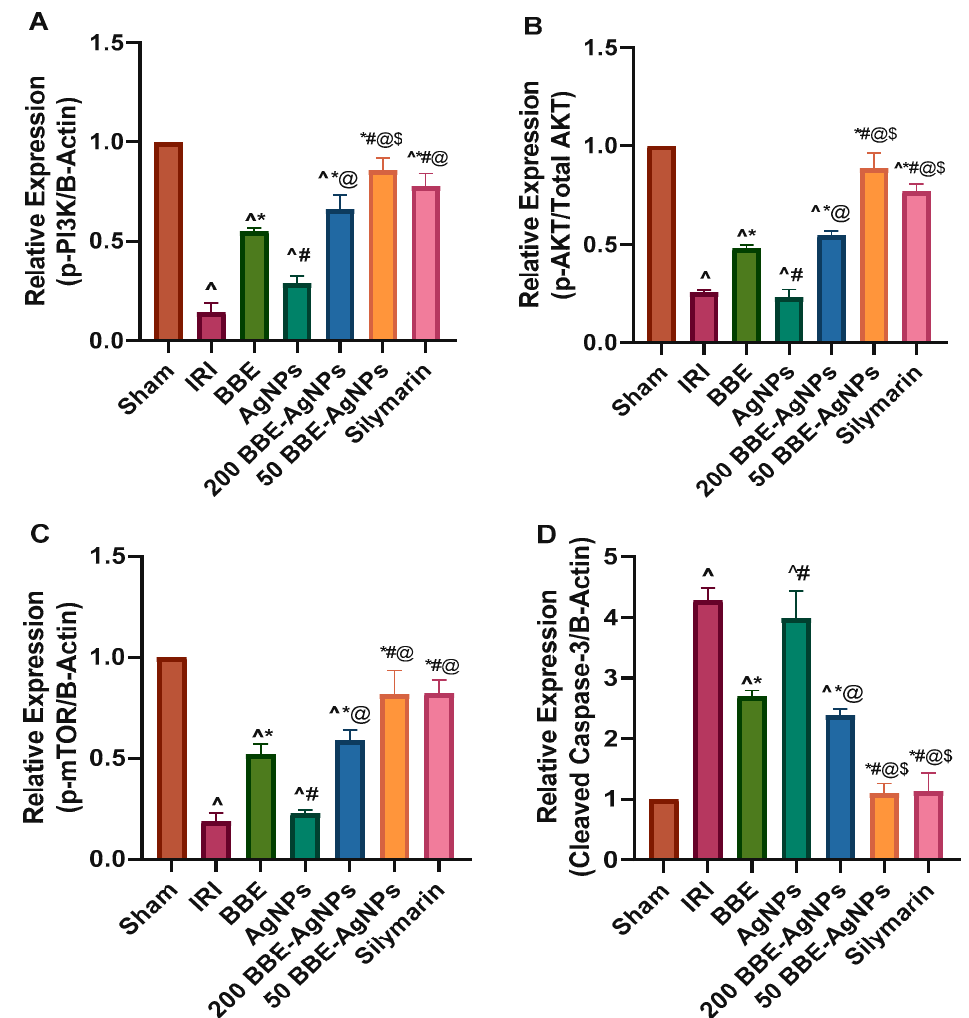
Figure 8. Quantitative analysis of affected proteins showing the effect of pretreatment with BBE , AgNPs, 200 or 50 BBE ‐ AgNPs and Silymarin on the relative protein expression of ( A ) p ‐ PI3K, ( B ) p ‐ AKT, ( C ) p ‐ mTOR and ( D ) cleaved caspase ‐ 3 in I/R injured rats. Values are presented as means of